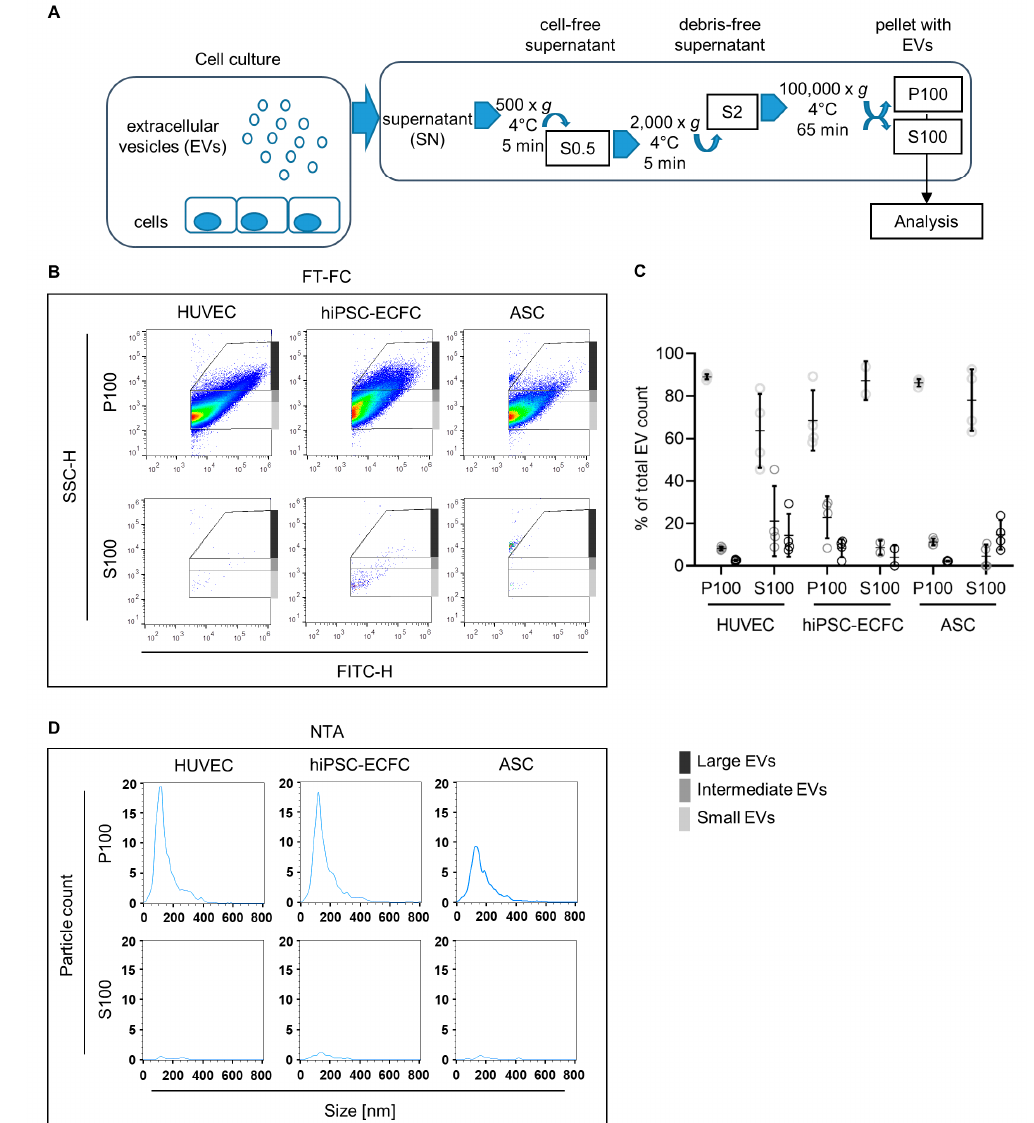
Figure 7. Characterization of particles released from HUVEC, hiPSC-ECFC, and ASC using nanoparticle tracking analysis (NTA) and fluorescence-triggered flow cytometry (FT-FC). ( A ) The obtained cell culture supernatants were cleared from debris and large particle conglomerates via centrifugation at 500 and 2000× g for 5 min each. Total EVs, including larger and smaller EVs were enriched by ultracentrifugation for 65 min at 100,000× g (P100), which was used to analyze total particle and extracellular vesicle (EV) count via scatter and fluorescence mode nanoparticle tracking analysis (NTA). The total size distribution was assessed via fluorescence-triggered flow cytometry (FT-FC). The remaining supernatant after the differential centrifugation procedure (S100) was analyzed for particle and EV count in order to check the efficiency of the enrichment. ( B ) Resulting representative density scatter plots of FT-FC analyzed EV enrichment show less detected events in the large EV gates (dark grey) for ASC compared to the EC (HUVEC and hiPSC-ECFC). Only a few events could be detected in S100 indicating a successful enrichment. ( C ) Quantification of EV presence in respective size range gates for FT-FC showing increased proportion of “Small” vesicles (light grey) in all cell types and a decrease of “Intermediate” (grey) and “Large” (dark grey) vesicles in P100. Missing percentages to 100% were detected outside the EV gates. Error bars indicate the mean values ± SD ( D ) Size distributions and particle counts of P100 analyzed via scatter mode NTA, for a representative sample of each cell type (HUVEC, hiPSC-ECFC, and ASC). Data was obtained from four independent experiments. n = 2 cell donors (HUVEC and ASC) and one cell donor